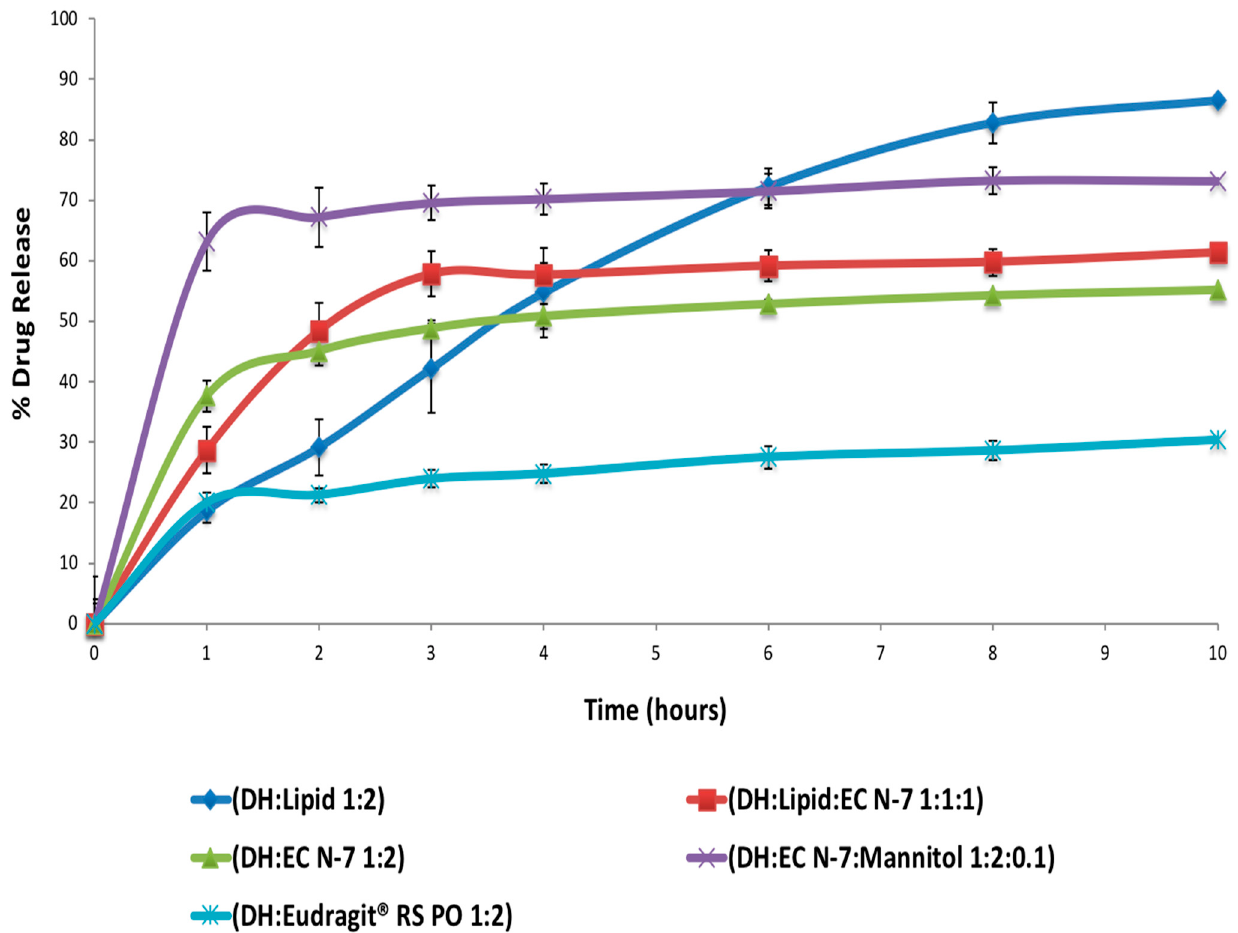
Figure 8. In vitro drug release of DH from different formulations (mean ± SD; n = 3).